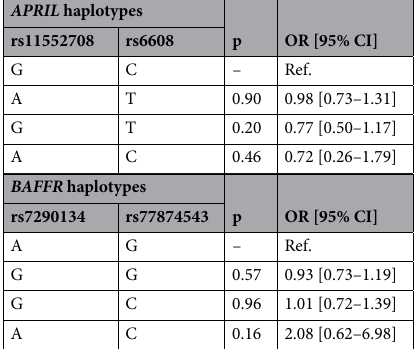
Table 4. Haplotype analysis of APRIL and BAFFR between patients with IgAV and healthy controls. IgAV: IgA vasculitis; OR: odds ratio; CI: confidence